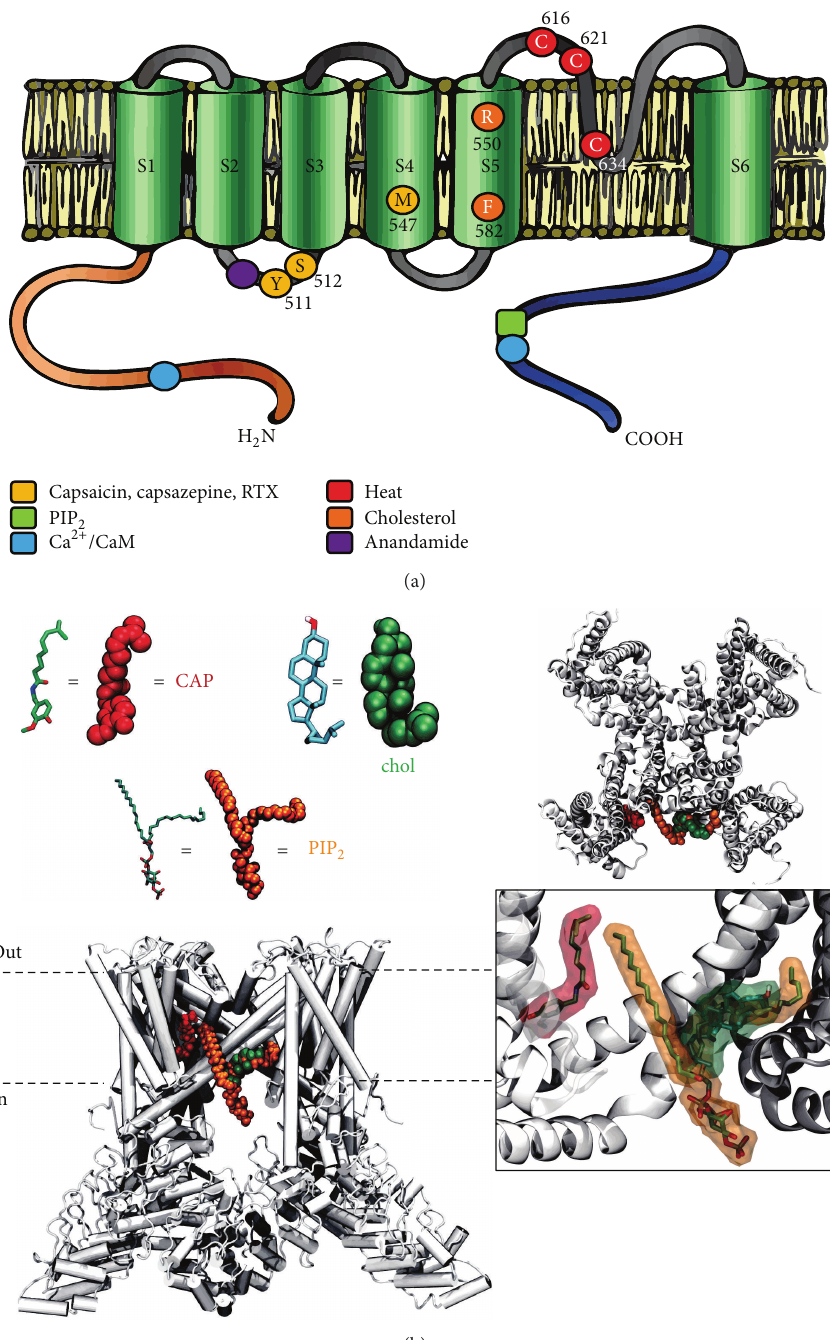
Figure 1: Diagram of regions involved in TRPV1 function. (a) The primary structure involves six transmembrane segments (S1–S6) with a pore domain between the fifth (S5) and sixth (S6) segment, and both C and N termini are located intracellularly. The functional TRPV1 receptor is believed to form a homotetramer. Amino acid residues involved in the binding of chemical and physical activation/modulation of TRPV1 activity are indicated in a color scheme. Vanilloid compounds, as the activators capsaicin and resiniferatoxin, as well as inhibitor capsazepine share the same binding site, while cholesterol-binding site is composed of a promiscuous hydrophobic pocket in S5. (b) Model for hydrophobic pocket in S5 linker with the binding of lipidic molecules such as cholesterol (chol), PIP 2 , and capsaicin (CAP) generated by molecular dynamics. In this binding conformation, all the molecules occupy a groove formed between S5 and C-terminal of the